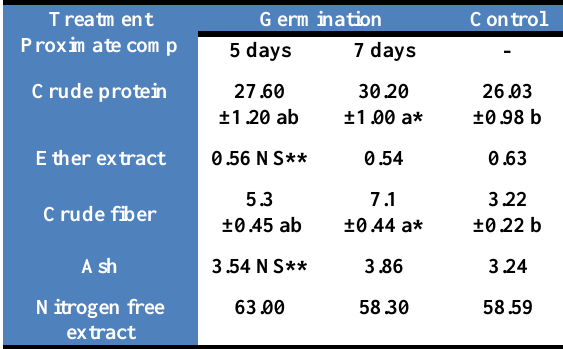
Table, 2: Effect of germination of common vetch for 5 and 7 days on crude protein, fat, crude fiber and ash (Rate ±